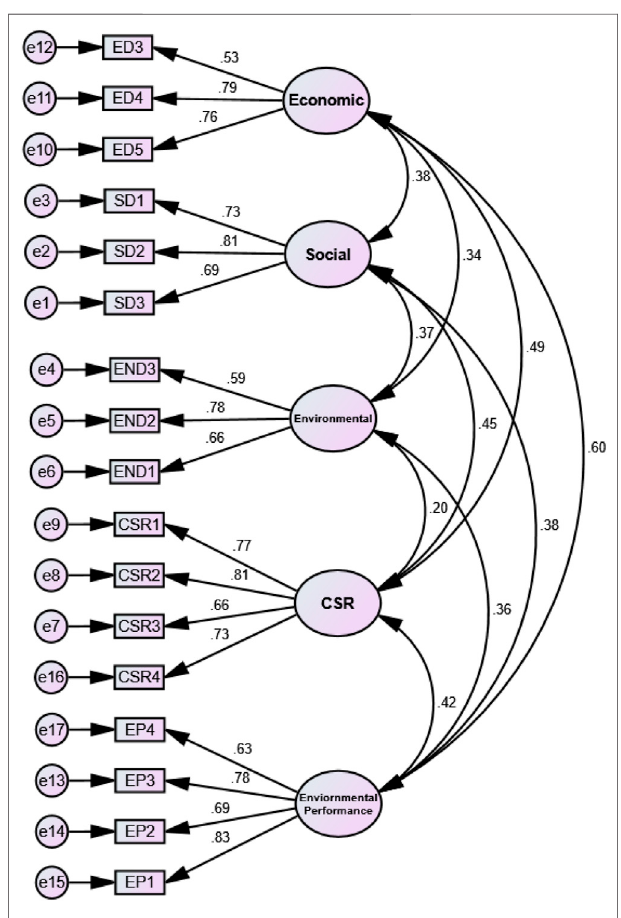
FIGURE 3 | CFA measurement model of the study.